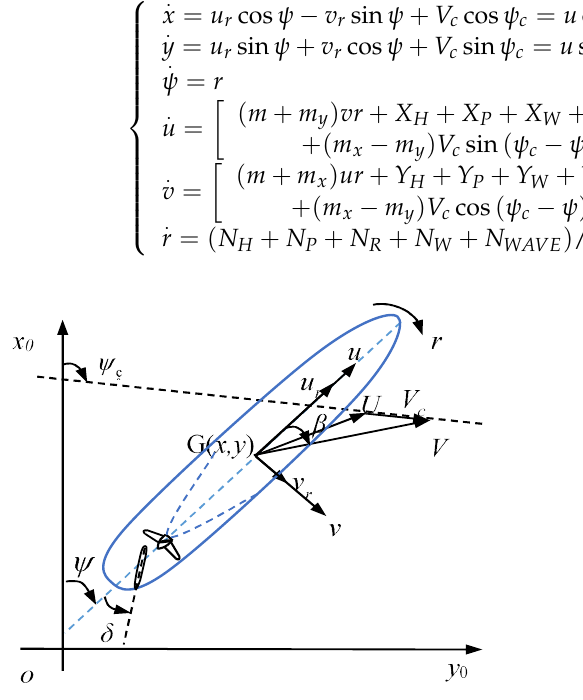
Figure 1. Ship plane position and motion parameters. In Equation (1), m is the mass of the ship; m x and m y are added mass; X H , Y H , and N H are the hydrodynamic forces and moments on the naked hull; X P , Y P , and N P are propeller force (moment); ψ c and V c are flow direction and velocity, respectively, X W , Y W , and N W are wind force (moment); X wave , Y wave , and N wave are wave force (moment); I zz is the